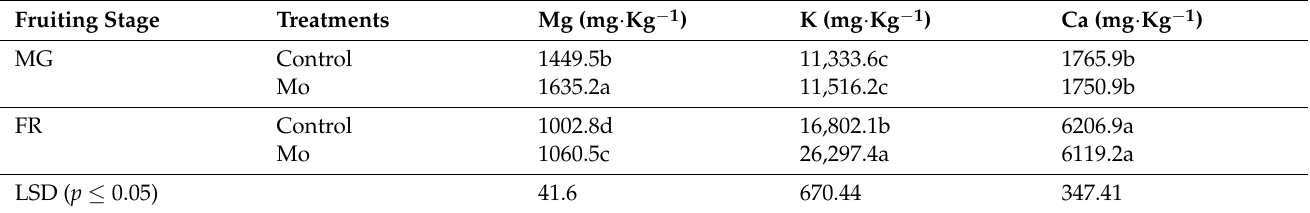
Table 5. Effect of foliar application of molybdenum on macronutrient concentrations in fruit peel of loquat. Fruiting